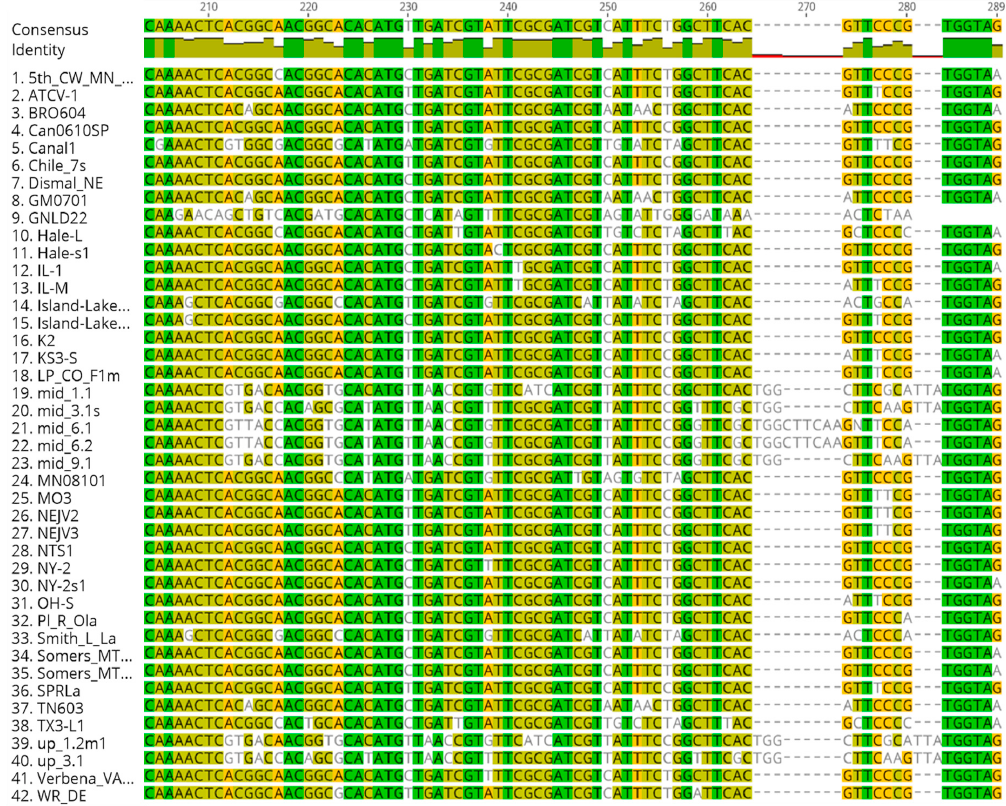
Figure A1. DNA sequence alignment of unique SAG chlorovirus kcv genes. DNA sequences were aligned using the Geneious Alignment algorithm from Geneious 11.0.5 software. Green color indicates identical nucletides among all sequenced strains. Different shades from olive to orange denote different degrees of conservation with olive color being the most conserved.